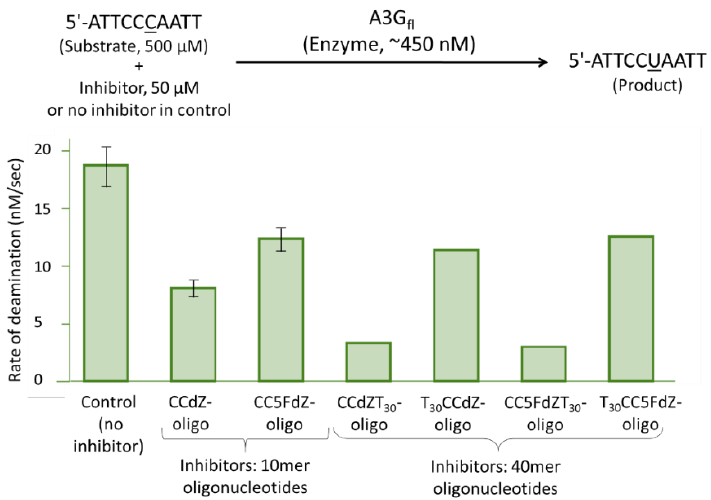
Figure 2. Qualitative screen of modified oligos on the inhibition of the A3G fl -catalyzed deamination of the preferred dC substrate 5’ -ATTCCCAATT (CCC-oligo). Plot of the initial speed of deamination of 500 μM 5’ -ATTCCCAATT (target dC underlined) by the A3G fl in the absence or presence of 50 μM CCdZ - or CC5FdZ-containing 10- and 40-mer oligos. Experiments were performed using the 1 H-NMR-based inhibition assay in pH 6.0 kinetic buffer (100 mM NaCl, 50 mM sodium phosphate, 10 % D 2 O, 1 mM citrate, 50 μM DSS) at 298 K. Experiments with 10 -mer oligonucleotides were repeated multiple times, and the mean values were plotted with error bars reported as SD, whereas single experiments were performed on the 40-mer oligos. Full inhibitor sequences are given in Materials and Methods.